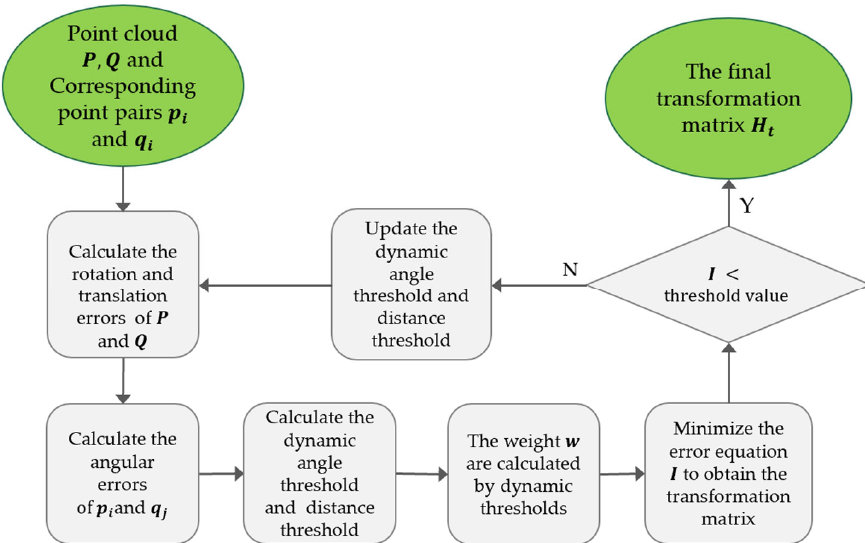
Figure 8. Registration with dynamic iteration factors.